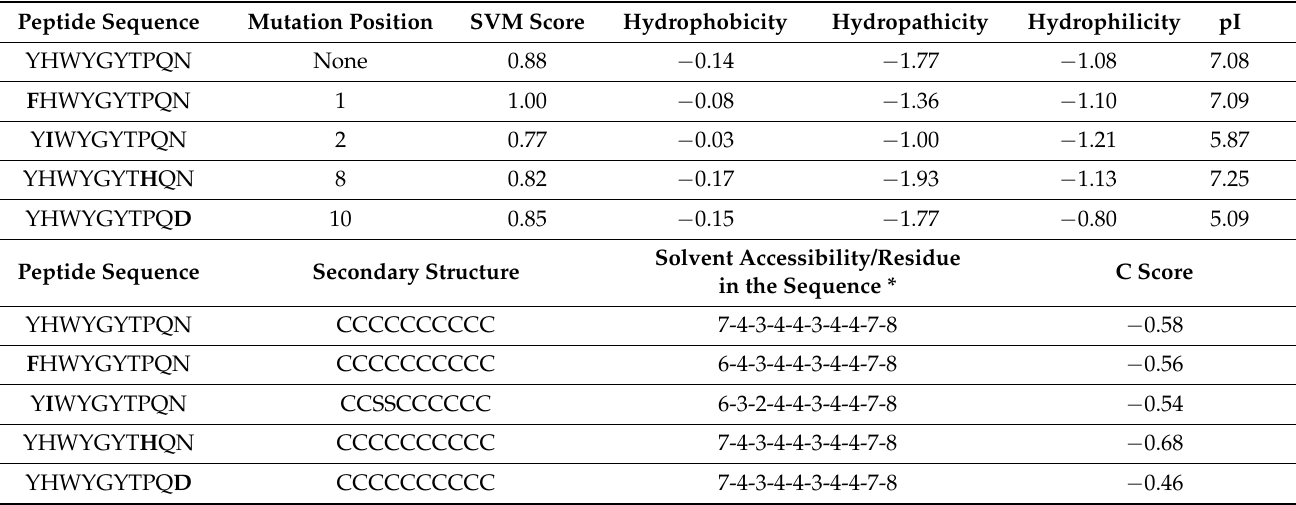
Table 3. Properties of Designed Anticancer Peptides, ( a ) Peptide AntiCP Results, ( b ) I-TASSER